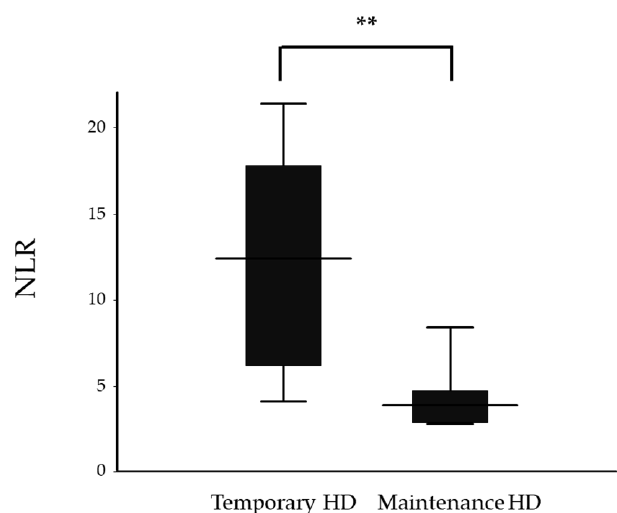
Figure 4. Neutrophil-to-lymphocyte ratios (NLR) of the temporary and maintenance hemodialysis (HD) groups. The top and the bottom of the boxes are the first and third quartile, respectively. The length of the box represents the interquartile range. The line through the middle of each box represents the median. The error bars show the minimum and maximum values (range). **, p < 0.01.